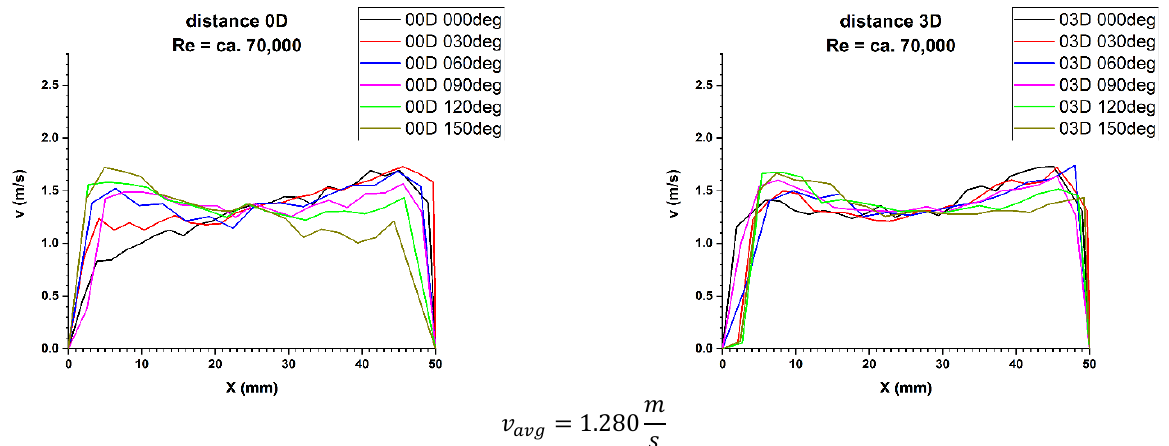
Figure 9. Comparison of velocity profiles at a distances 0D and 3D from the disturbance with marked cross-sections for Re ≅ 70,000-The LDA measurement taken in the ultrasound wave path.